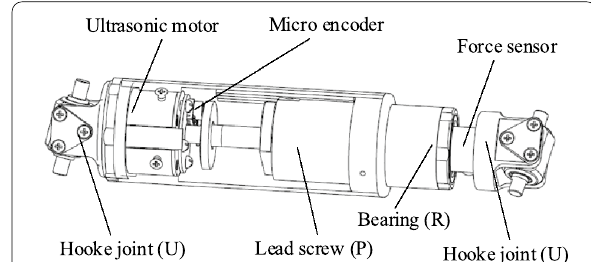
Figure 5 Structure of the UCU chain